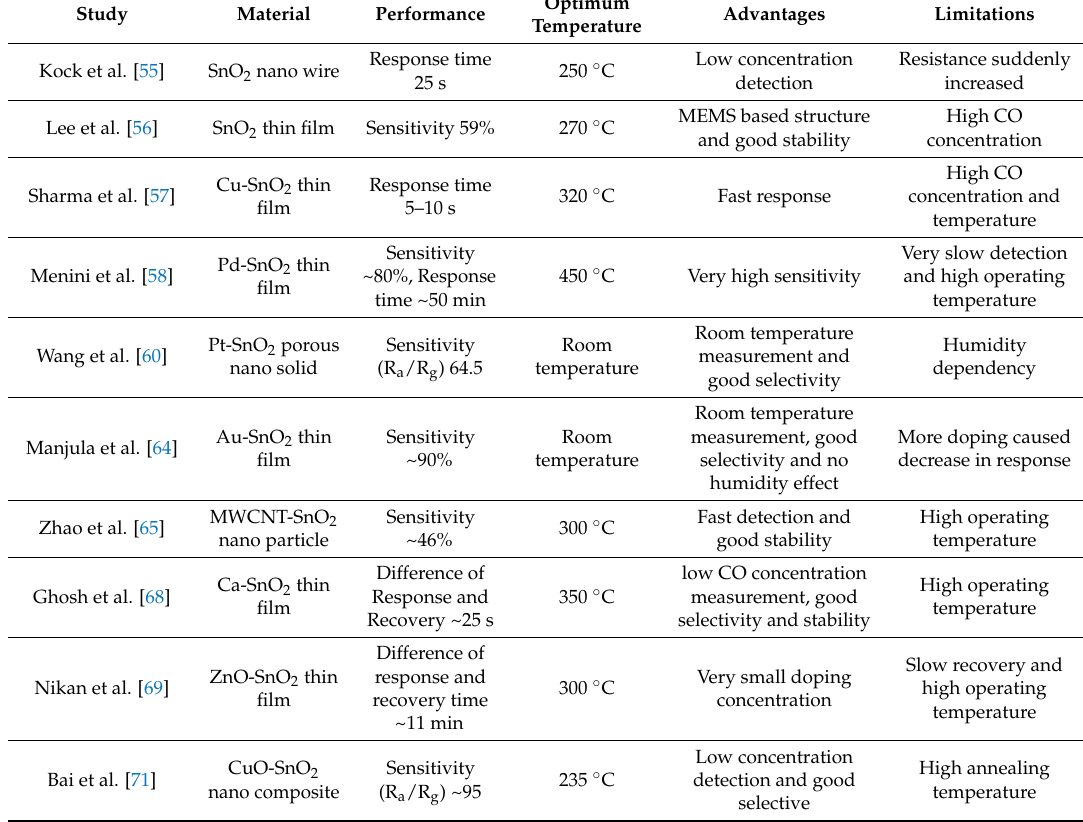
Table 2. Brief summary of the SnO 2 based MOS materials for CO detection.